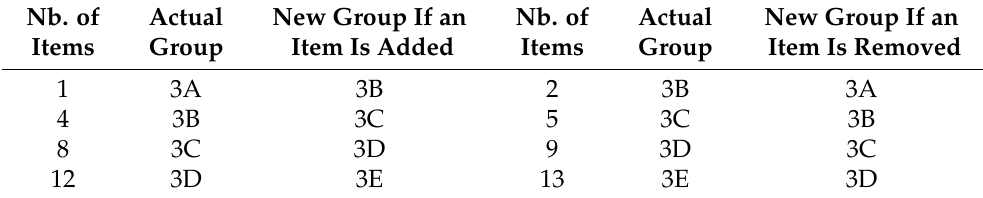
Table 8. List of farms analyzed for the transition study. Nb.